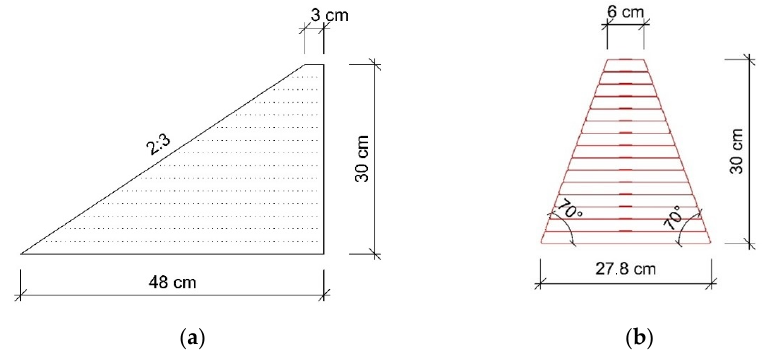
Figure 4. Geometry of the two types of embankments: ( a ) earth dam without geotextiles, inclination 2:3 on the impact side; ( b ) reinforced dam with geotextiles, inclination 70° on the impact side.